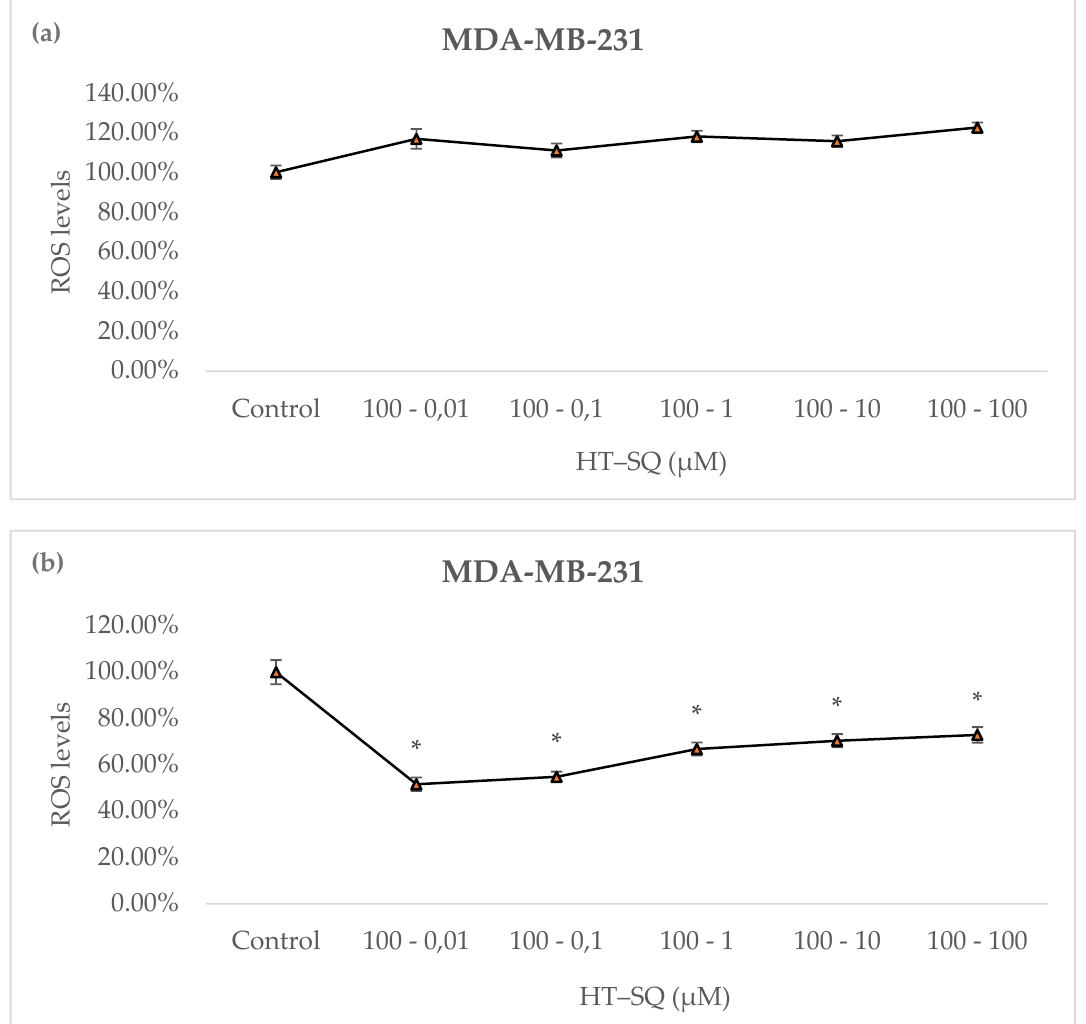
Figure 4. ROS levels represented in MDA-MB-231 cells in basal state ( a ) and with H 2 O 2 burst ( b ) after treatment with HT at 100 µ M, combined with SQ (from 0.01 to 100 µ M) for 24 h, followed by another 24 h with fresh medium. Data are represented as mean ± SEM of 3 independent experiments (* p < 0.05).